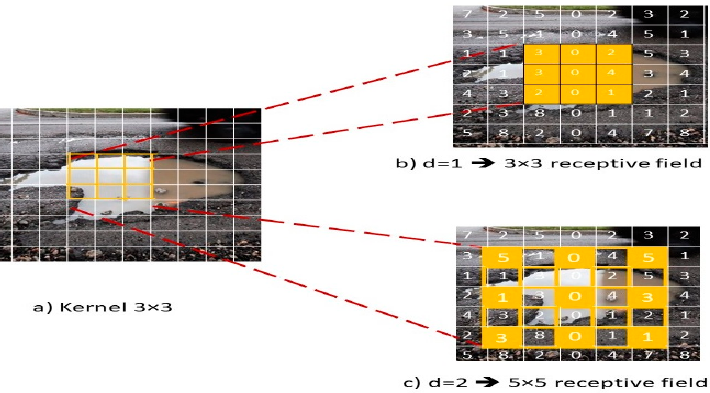
Figure 2. Dilated convolution: ( a ) original image with 3 × 3 kernel, ( b ) applying dilation rate of 1 with 3 × 3 kernel produces receptive field with size 3 × 3, and ( c ) applying dilation rate of 2 with 3 × 3 kernel produces receptive field with size 5 × 5, as a result the filter could grab more contextual information.